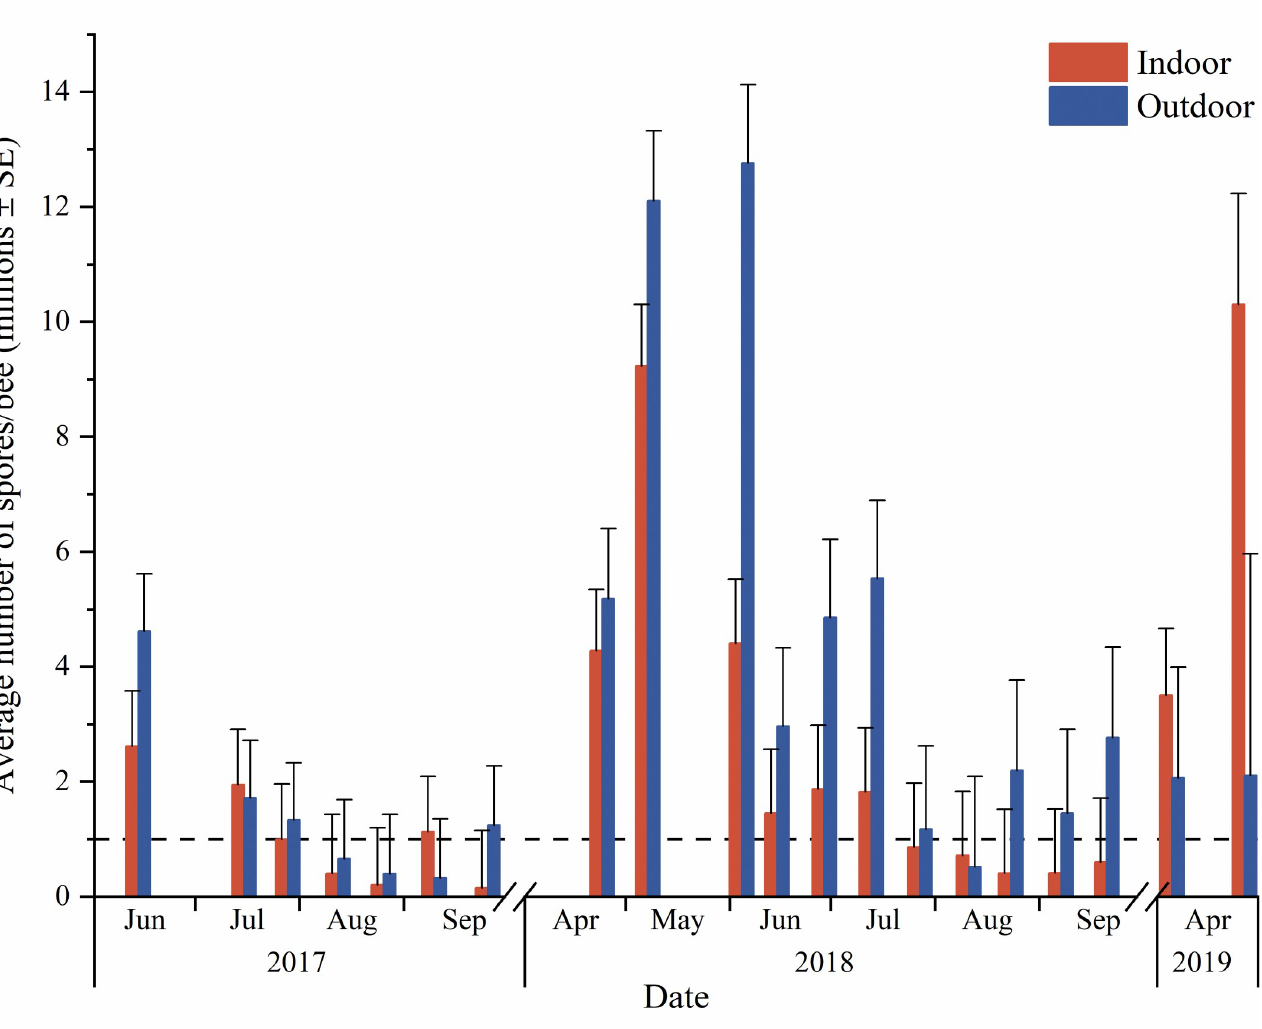
Fig 3. Influence of wintering method on average Nosema abundance over 23 months. Indoor represents colonies moved to an indoor wintering building, and outdoor represents colonies kept outdoors in insulating wraps. Data are plotted as untransformed means. Dashed line shows the historical 1 million spores/bee nominal